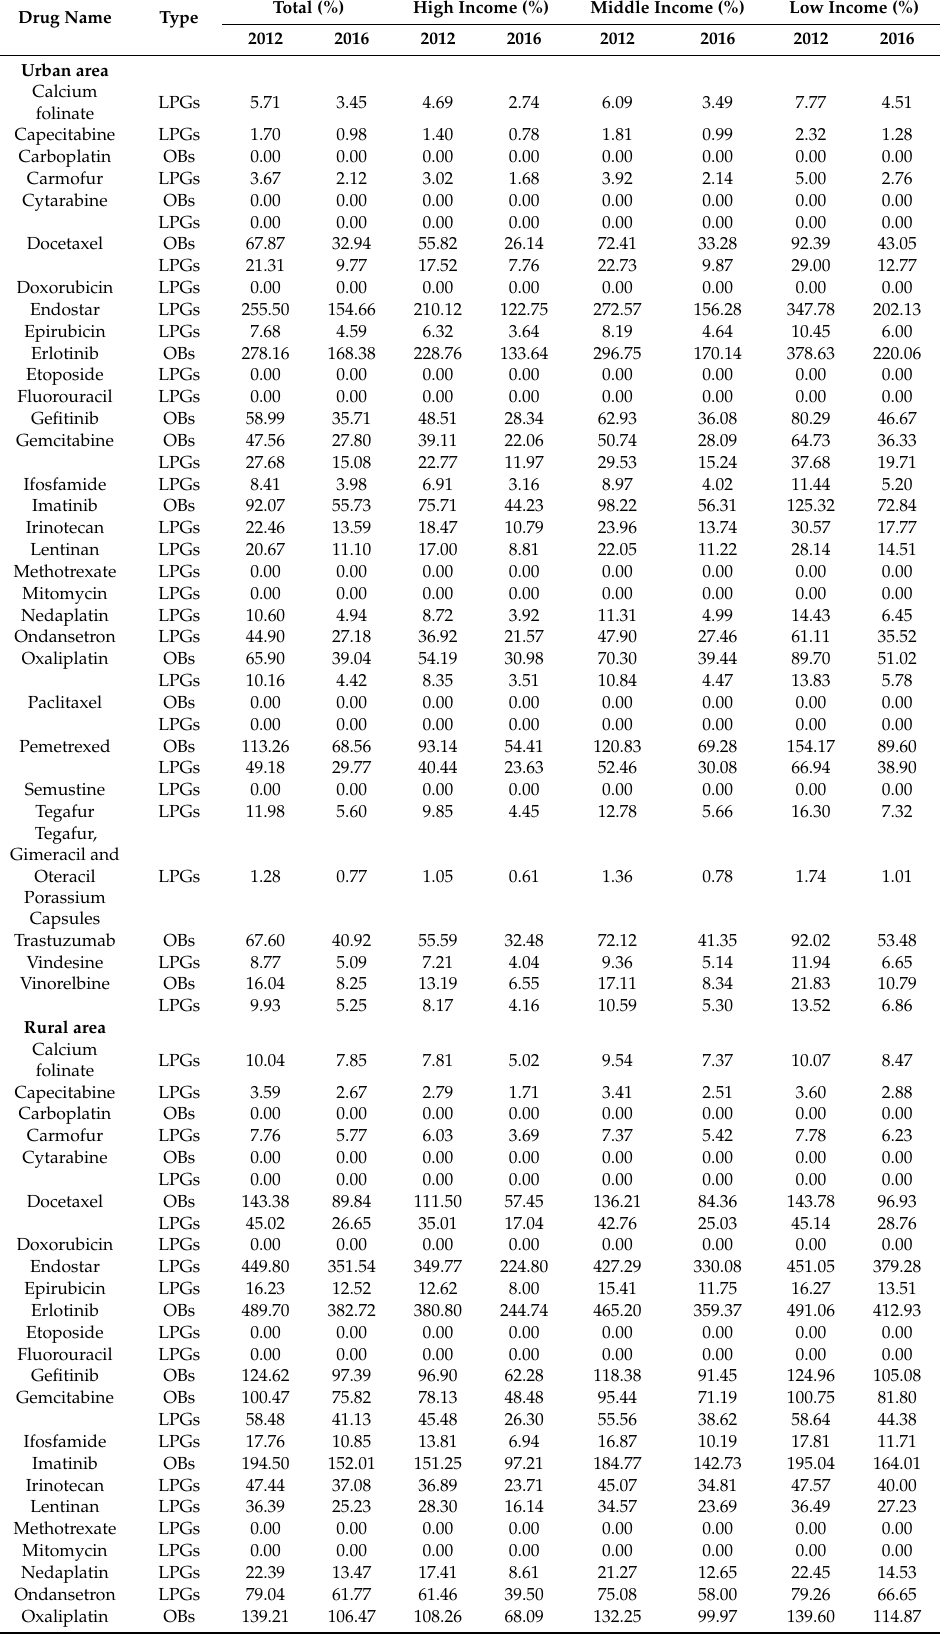
Table 8. A ff ordability of anticancer medicines in the urban and rural area in di ff erent regions of the Jiangsu Province after